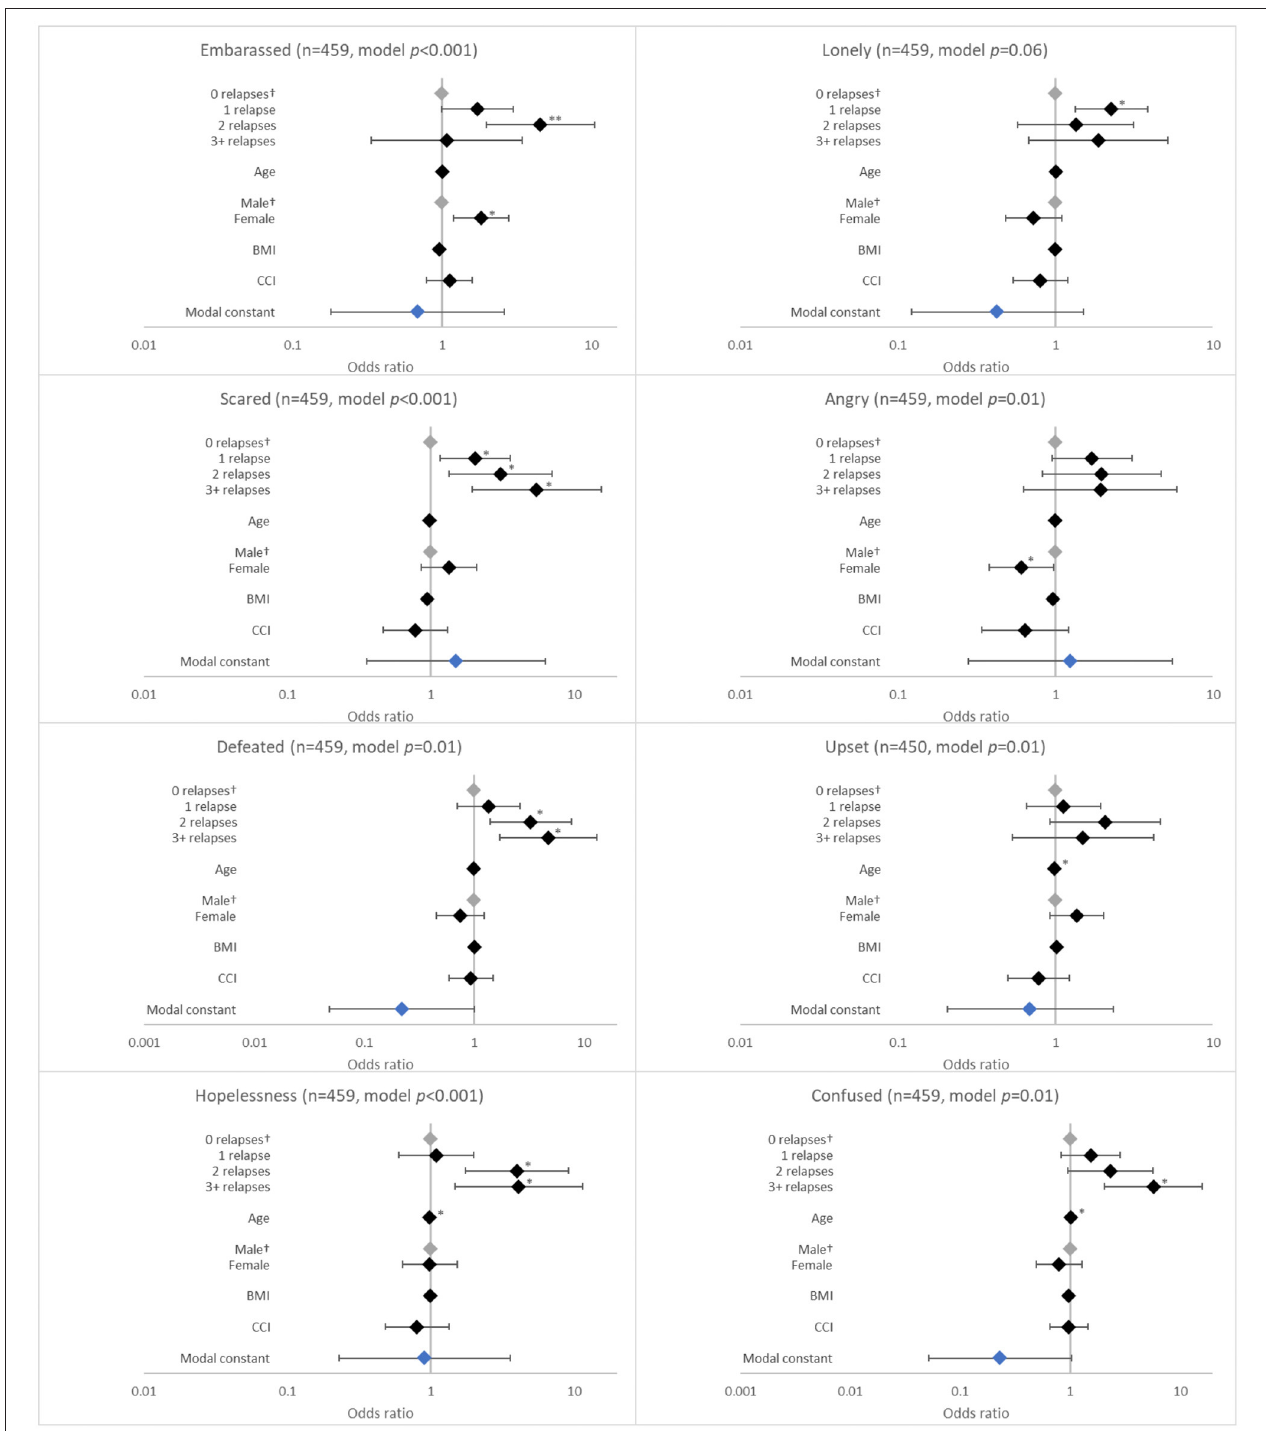
FIGURE 4 | Association between patient-reported emotions and the number of relapses in the last 12 months. † Base level, * p < 0.05 and ** p < 0.001. Likelihood ratio p -values are referenced in Table 2 . BMI, body mass index; CCI, Charlson comorbidity index. Grey diamonds indicate base level. Blue diamond indicates the model